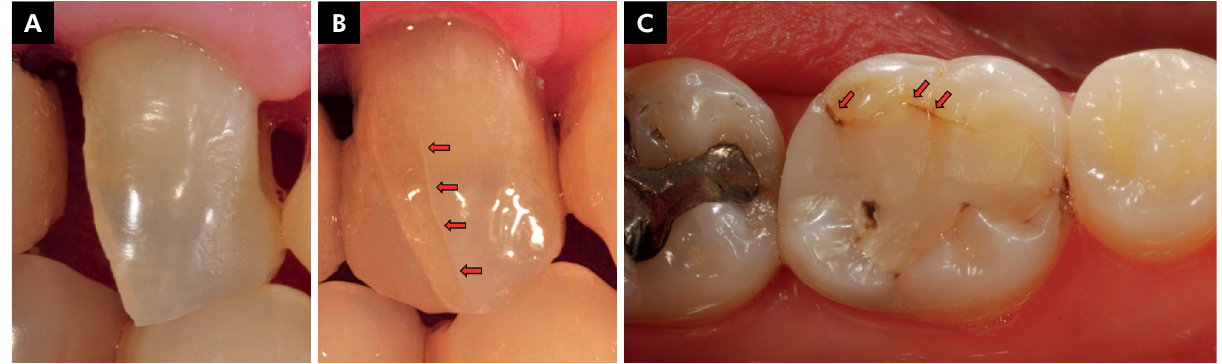
Figure 2. Clinical signs of polymerization shrinkage; A. Buccal cusp after deep caries removal showing no enamel crack; B. Enamel crack (red arrows) generated immediately after incremental filling composite resin restoration; C. Marginal staining (red arrows) of the restoration after 5 years in function.